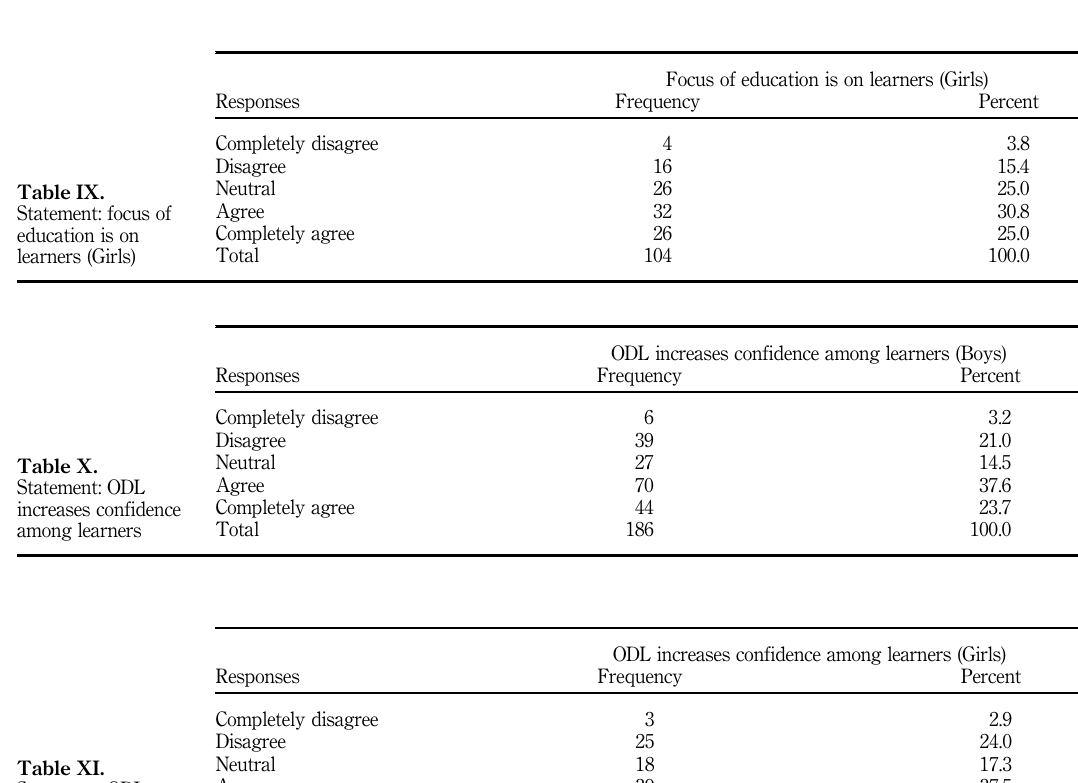
Table XI. Statement: ODL increases confidence among learners